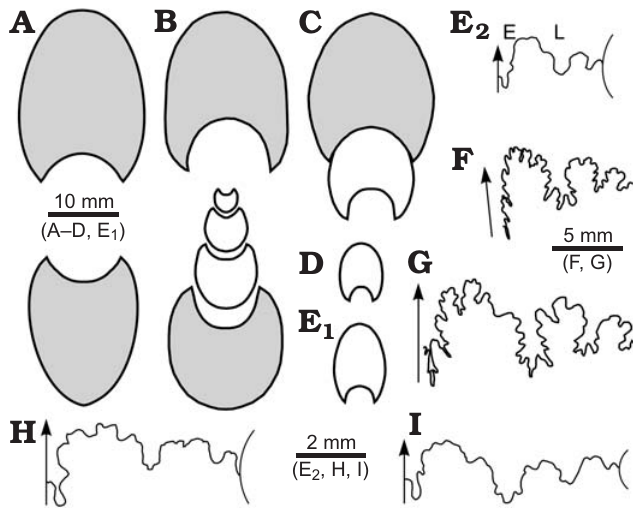
Fig. 6. Morphoceratid ammonite Polysphinctites tenuiplicatus (Brauns, 1865) [M and m], Lower Bathonian, Polysphinctites tenuiplicatus Zone, Polish Jura, Kawodrza Górna and Faustianka. Representative whorl sections (A–D, E 1 ), body chamber gray; and septal suture lines (E, E 2 , G–I). A–D , G . Macroconchs, females. A . GIUS 8-2736. B .GIUS 8-2715. C . GIUS 8-2713. D . GIUS 8-2735. G . GIUS 8-2595. E , F , H , I . Microconchs, males. E . GIUS 8-2590. F . GIUS 8-2616. H . GIUS 8-2702. I . IGPUW/J/129. Nomenclature: E, external lobe; L, lateral